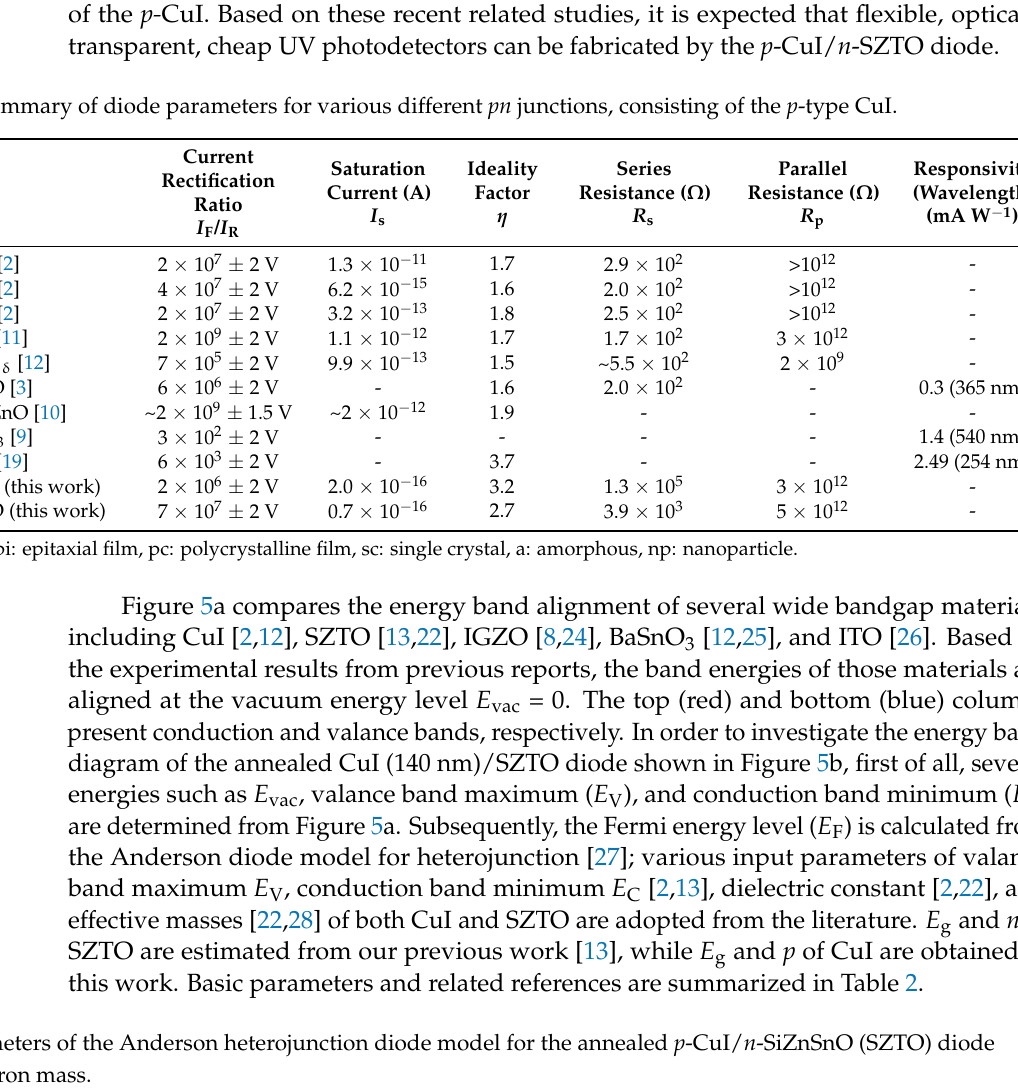
Table 1. Summary of diode parameters for various different pn junctions, consisting of the p -type CuI. pn Diode pc-CuI/epi-ZnO [2]